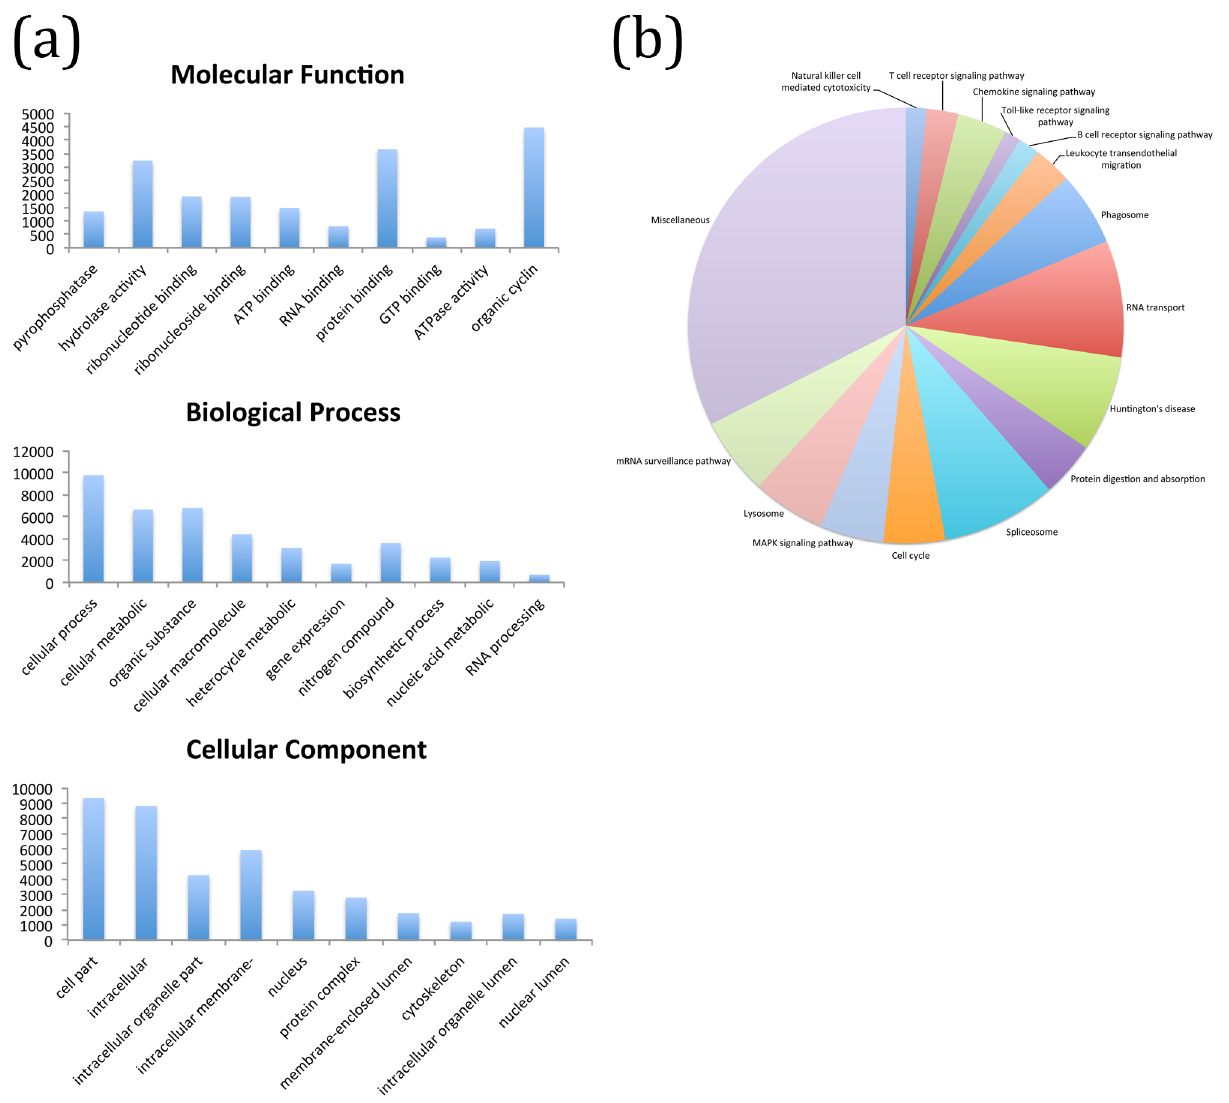
Figure 2. (a) Enriched Gene Ontology (GO) terms assigned to differentially expressed genes (DEGs) in uninfected and Opisthorchis viverrini -infected Bithyniasiamensisgoniomphalos snails (UB and IB, respectively), according to the categories ‘biological process’, ‘cellular component’ and molecular function; (b) enriched KEGG biological pathways assigned to DEGs in UB and IB, respectively.